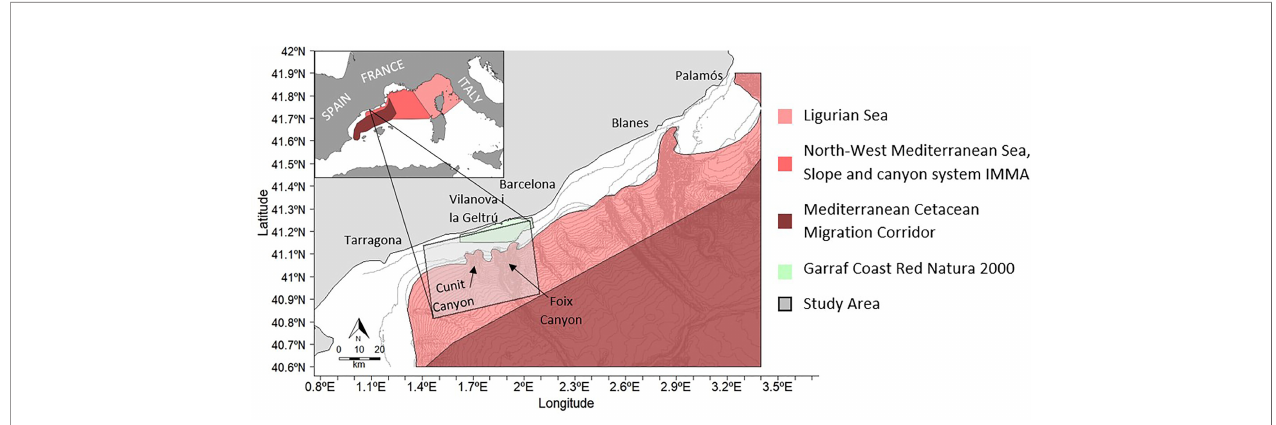
FIGURE 1 | Fin whale project study area along the Garraf coast. The Foix Canyon (largest system) is located on the right side of the study area and the Cunit canyon is situated on the left side. The bathymetry lines have an interval of 50 meters. In the top left it can be seen an image of the W- Mediterranean in which there are represented the SPAMI areas;.In dark red the cetacean corridor, in light pink the Pelagos Sanctuary, in red the North-West Mediterranean Sea, Slope and canyon system IMMA a.nd in light green the Garraf Coast Red Natura